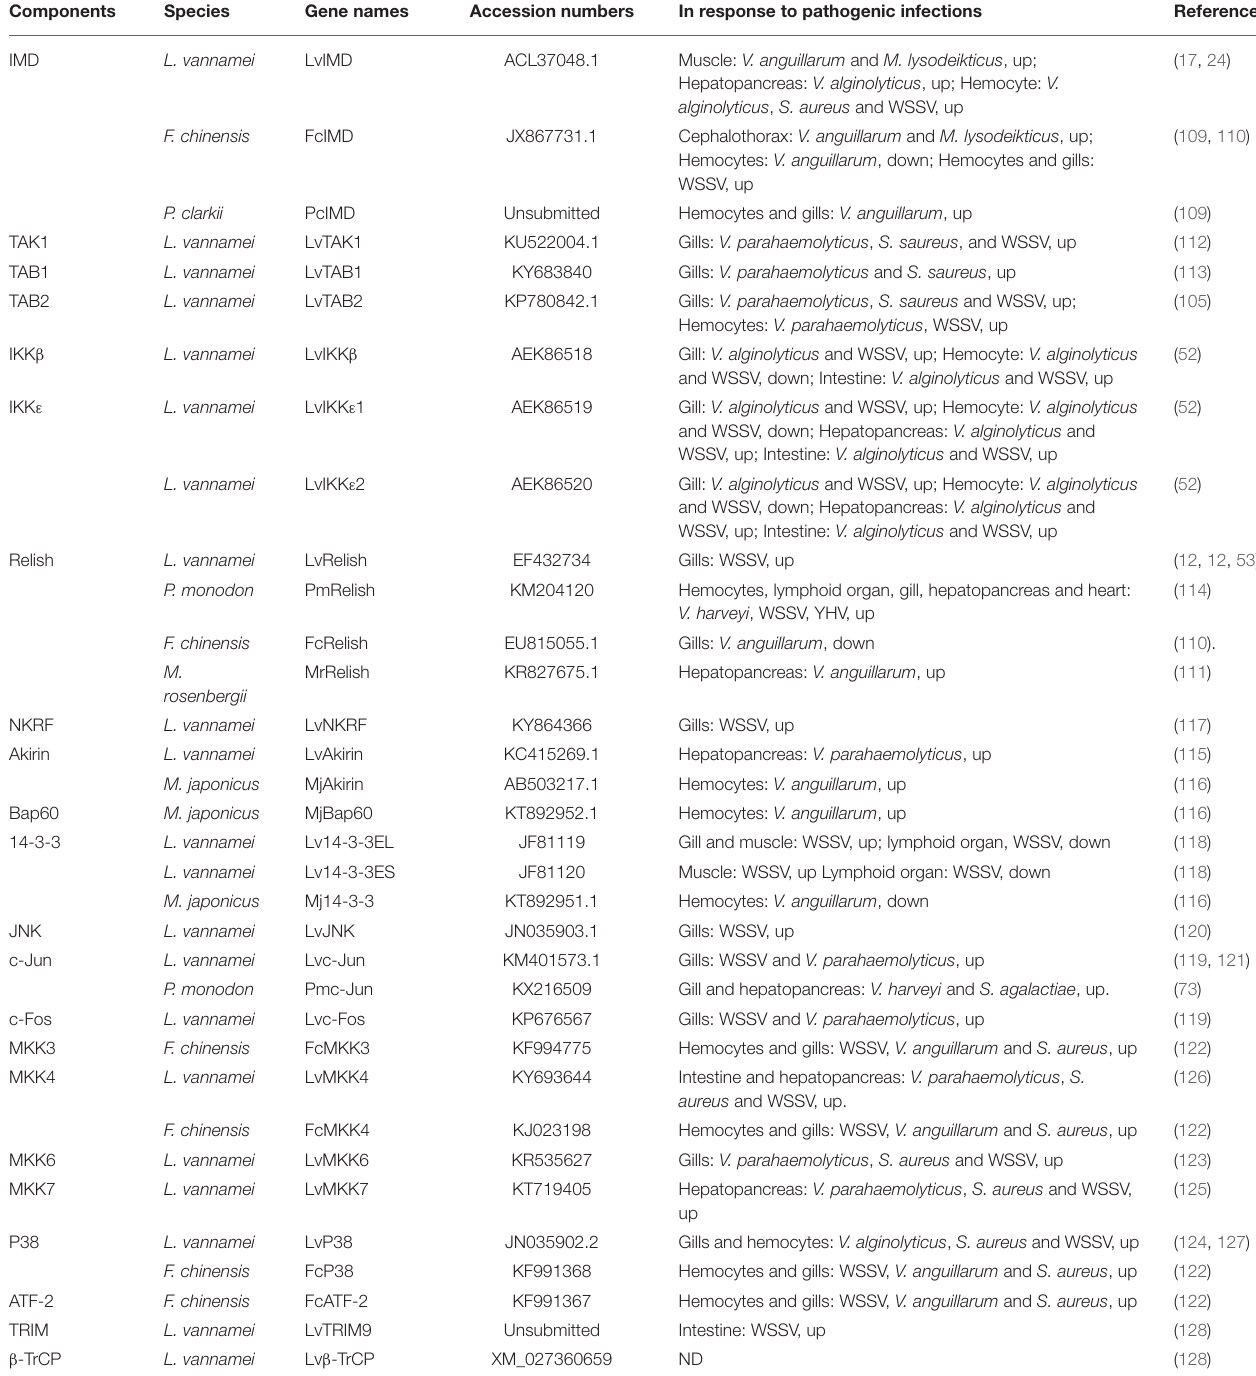
TABLE 2 | Components of canonical IMD signaling pathway identified in shrimps.